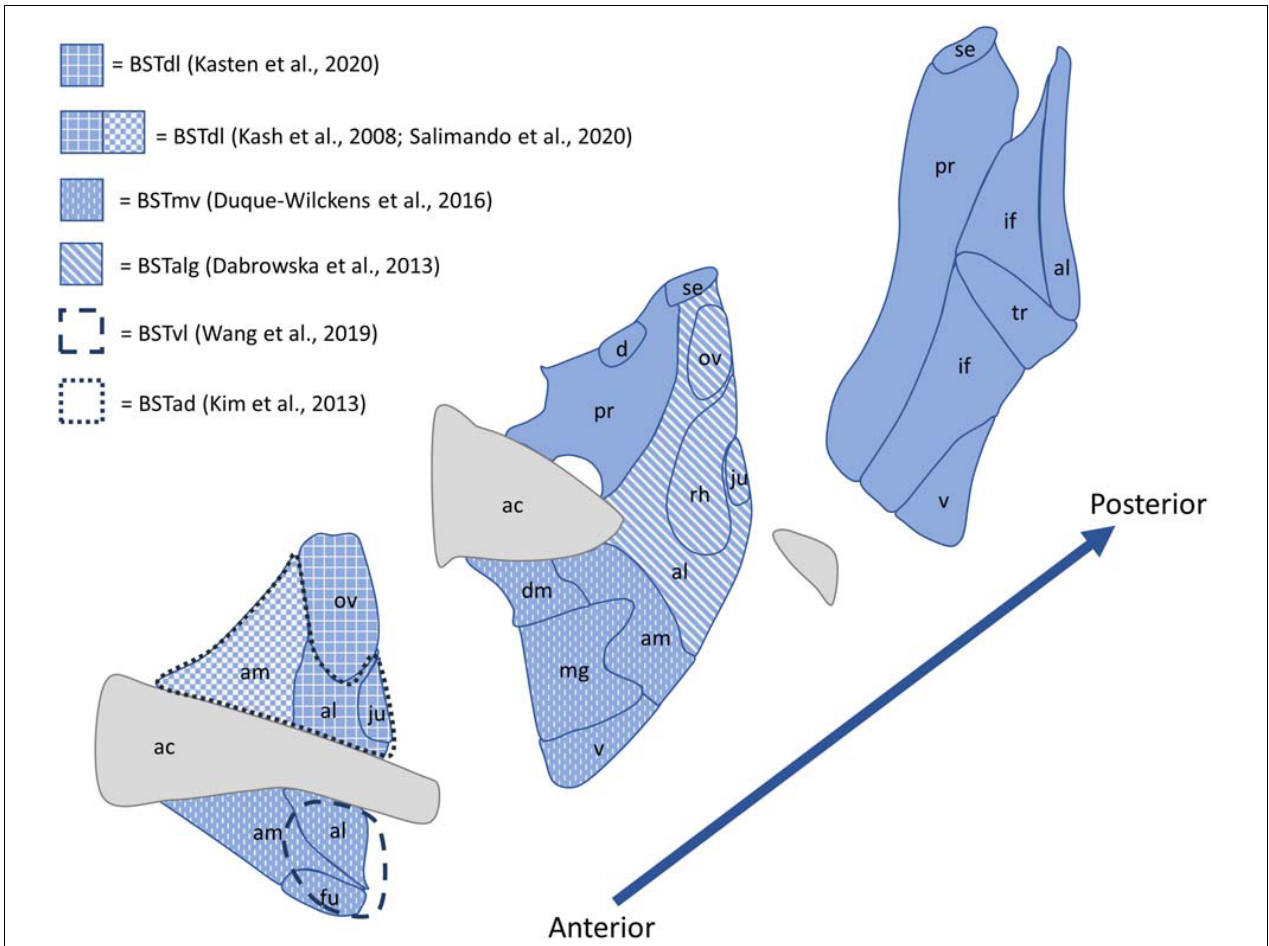
FIGURE 2 | Diagram of the BST nuclei as described by the Allen Brain Adult Mouse Reference Atlas shown in blue, with white patterns and dashed lines indicating the nomenclature used to described the regions referenced by papers included in this review. Abbreviations: ac, anterior commissure; ad, anterodorsal; al, anterolateral area; alg, anterolateral cell group; am, anteromedial area; d, dorsal nucleus; dl, dorsolateral; fu, fusiform nucleus; if, interfascicular nucleus; ju, juxtacapsular nucleus; mg, magnocellular nucleus; mv, medioventral; ov, oval nucleus; pr, principal nucleus; rh, rhomboid nucleus; se, strial extension; tr, transverse nucleus; v, ventral